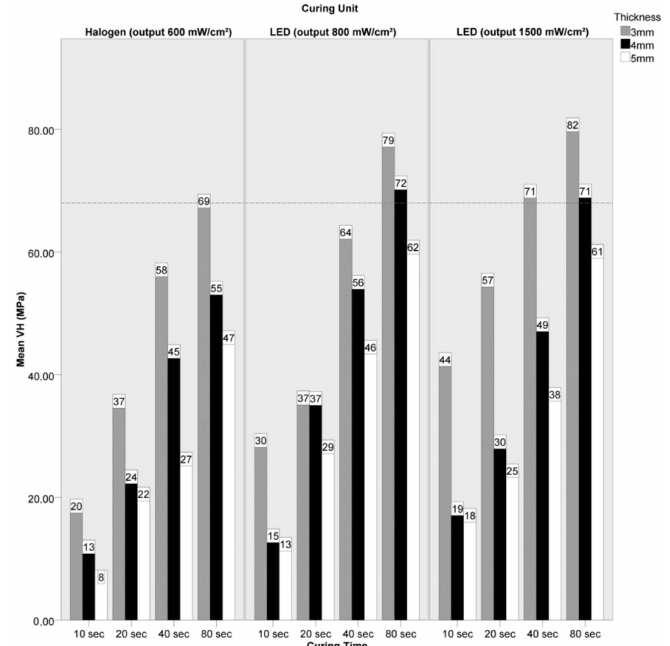
Figure 4. Bar chart summarizing mean Vickers Hardness (VH) numbers obtained in the ENA group using overlays of different thicknesses and after 10, 20, 40 or 80 s curing time. The horizontal line indicates 80% of the VH value achieved in the respective control group, which was used as the acceptability threshold for this material.